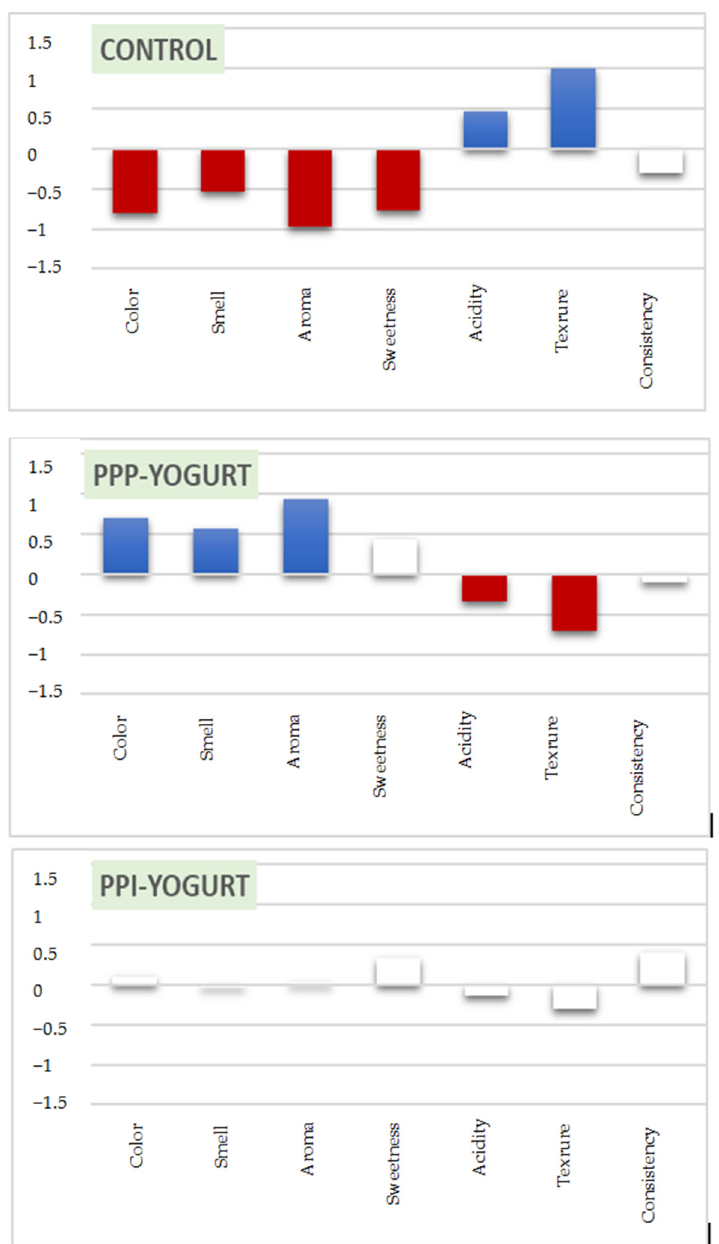
Figure 4. Results of the yogurt characterization. PPP-YOGURT: yogurt fortified with potato peel powder, PPI-YOGURT: yogurt fortified with potato peel pieces. The low intensities of the evaluated characteristics are designated in red, those of high intensity in blue, and those of medium intensity in white.